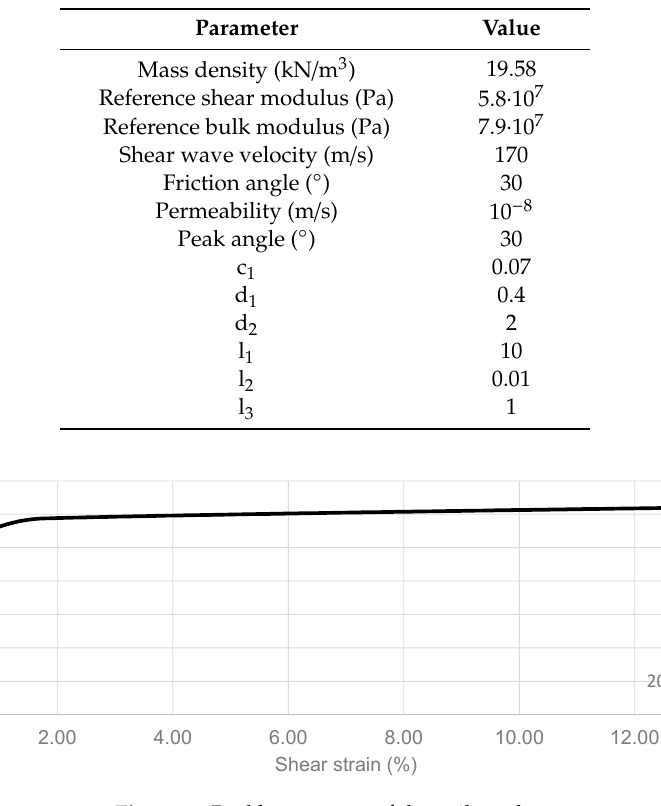
Figure 4. Backbone curve of the soil mesh. Table 4. Structural characteristics.